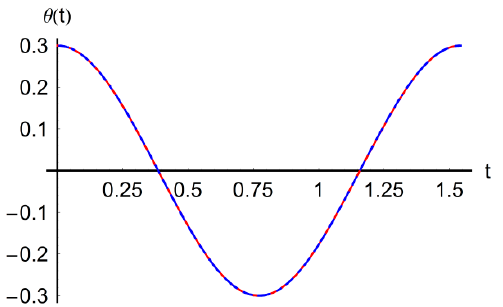
Figure 20. Comparison between the approximate solution (50) and numerical integration results for